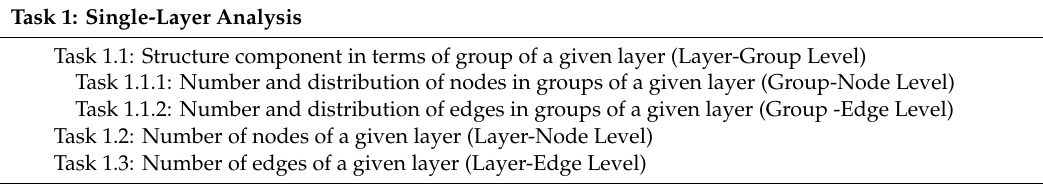
Table 1. List of tasks of layer-edge patterns analysis in multiplex